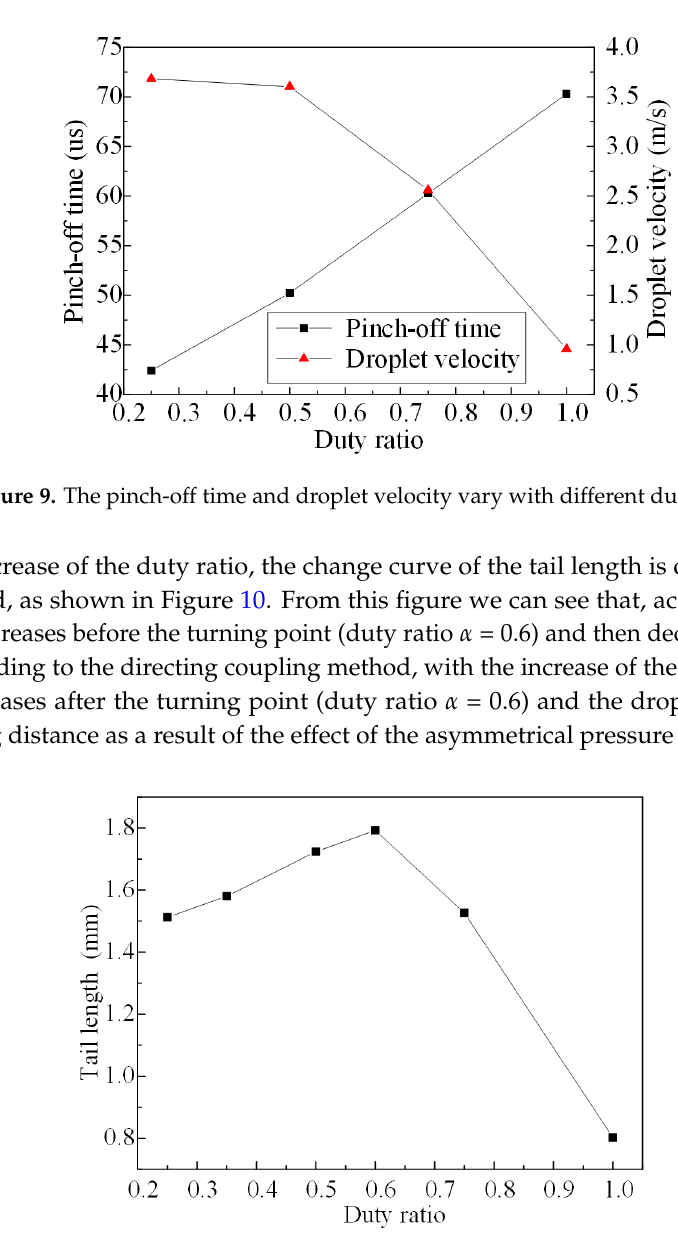
Figure 10. The tail length varies with different duty ratios.